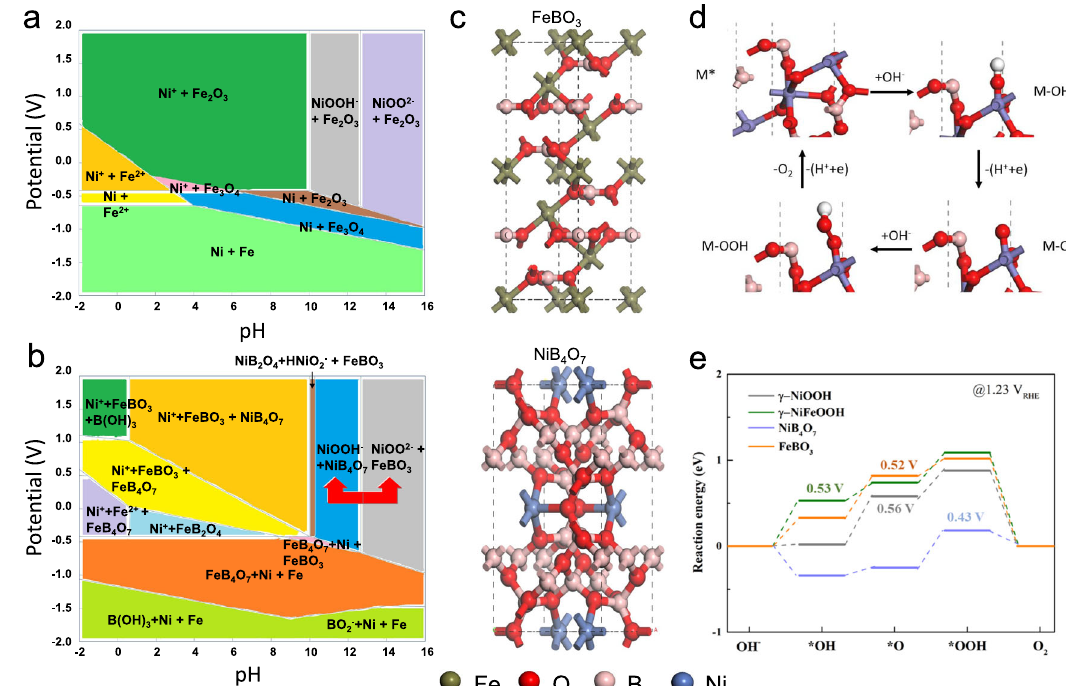
Fig. 1 Results of DFT calculations for NiFe-Boride catalysts. Pourbaix diagram of ( a ) NiFe and ( b ) NiFe-Boride; ( c ) The cell con fi gurations of NiB 4 O 7 and FeBO 3 ; ( d ) The schematic illustration of the 4-step OER pathway; ( e ) Predicted OER reaction energy diagram for NiB 4 O 7 , FeBO 3 , γ -NiOOH, and γ - NiFeOOH in the alkaline electrolyte at 1.23 V vs.